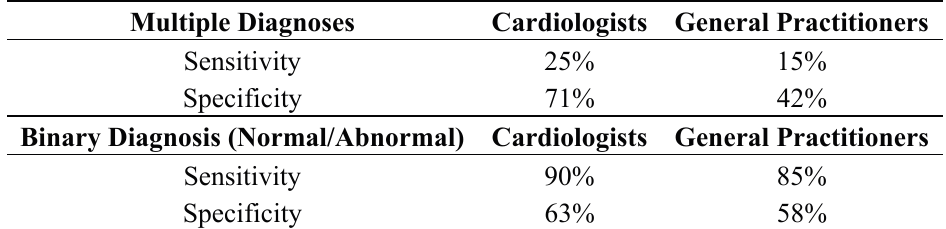
Table 3. Diagnostic accuracy of cardiologists and general practitioners assessing for